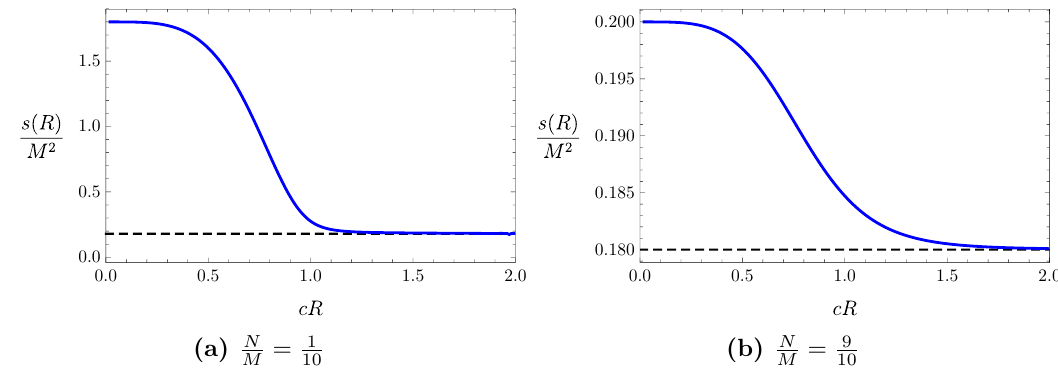
Figure 4. Numerical results for the function s ( R ), de(cid:12)ned in equation (4.30) as minus the log- arithmic derivative with respect to R of the brane’s contribution to the on-shell action in the entanglement wedge of a spherical subregion of radius R . For small cR the derivative tends to the coe(cid:14)cient of the logarithmic divergence of the on-shell action for the UV solution, the bundle of M2-branes. For large cR the derivative tends to the coe(cid:14)cient for the IR solution, the antisym- metric Wilson surface (indicated by the horizontal dashed lines). In between these limits, s ( R ) decreases